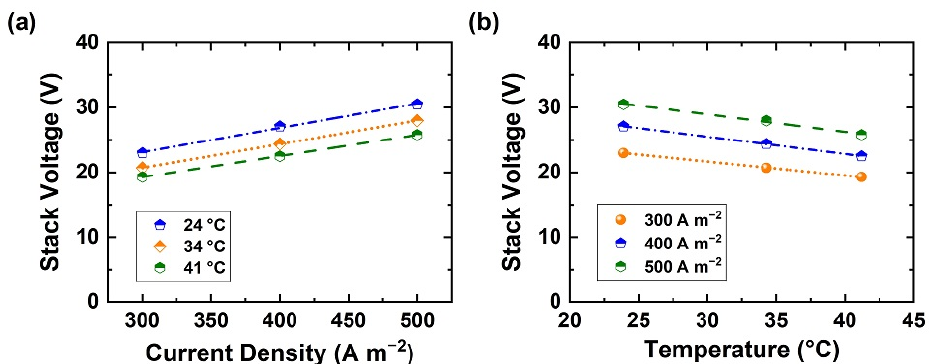
Figure 4. Cell voltage variation in Stack of 10 repeating units ( a ) at different current densities, and ( b ) at different temperature.